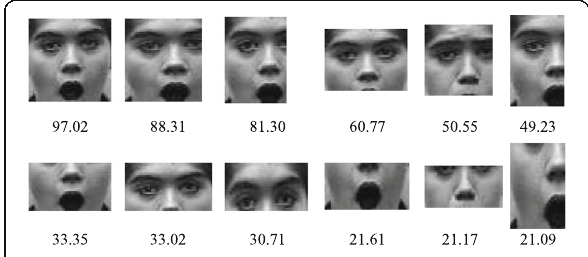
Fig. 6 Face regions with the recognition accuracies (%),